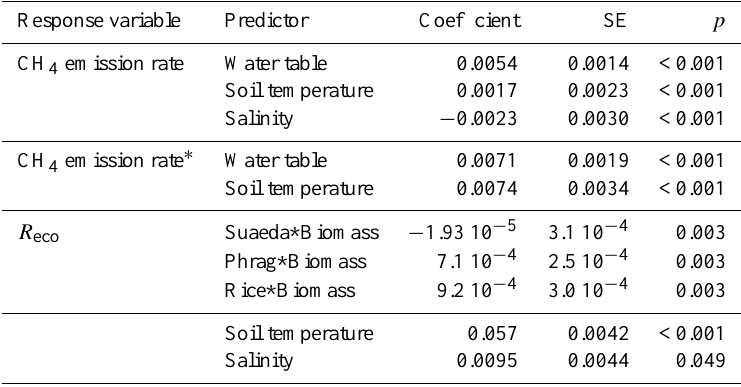
Table 3. Results from linear mixed-effects models, with CH 4 emission rate and ecosystem respiration rate ( R eco ) as response variables, and the fixed effects plant species, biomass, soil temperature, water table and salinity. Shown are the coefficients of the fixed effects to be included in Eq. (1), standard errors of the means and p values.